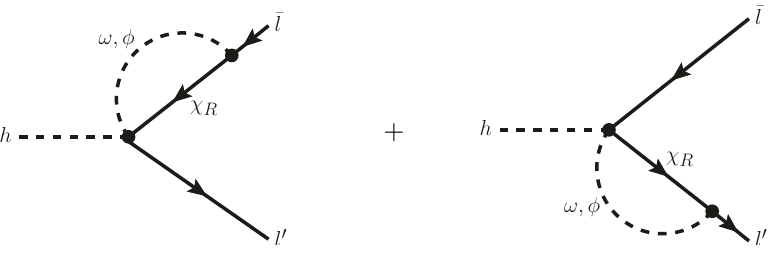
Figure 2 . Higgs decay diagrams exchanging the RH singlet in SO(5) quintuplets resulting in an unmatched divergent contribution when SM charged leptons get their mass from the usual (minimal) Yukawa